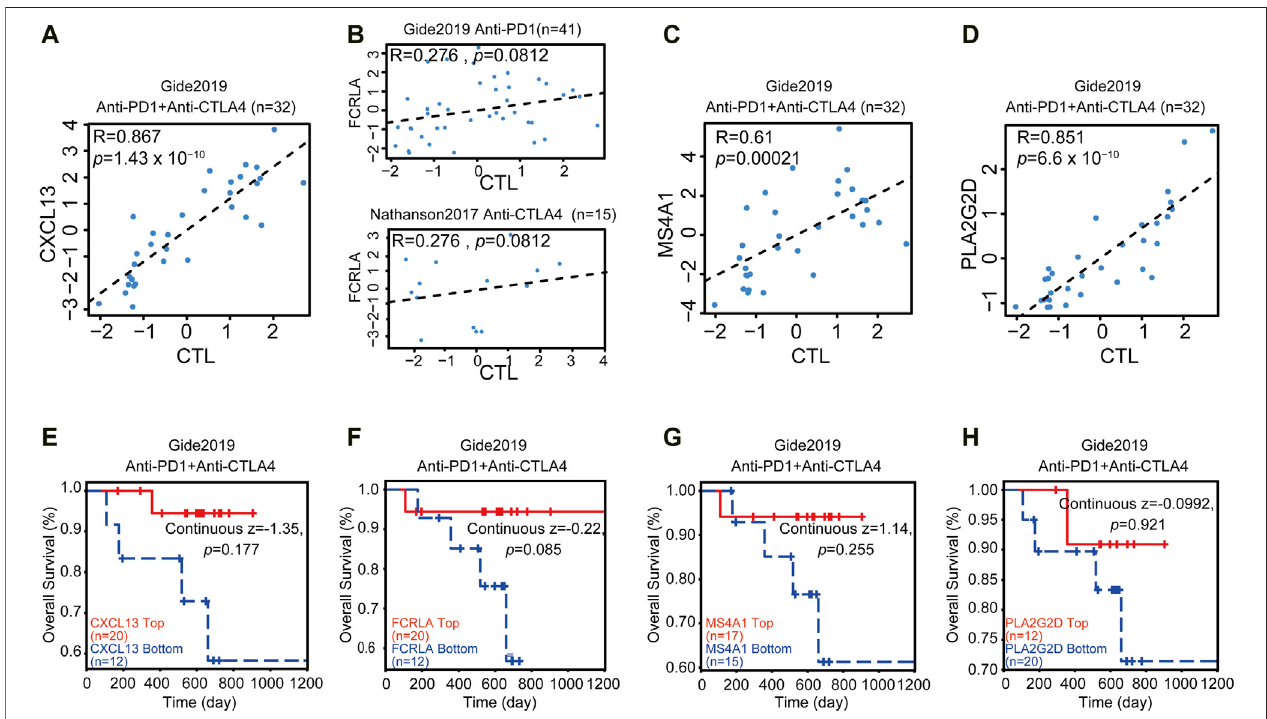
FIGURE6| CXCL13, FCRLA, MS4A1,and PLA2G2Dcorrelatedwithimmunotherapy. (A – D) Thescatterplotshows thecorrelation betweentheexpression levels ofCXCL13,FCRLA,MS4A1,PLA2G2D,andCTLin fi ltration.The x -axisshowsthelevelofCTLin fi ltrationineachmelanomasample.ThePearsoncorrelation(R)between theplottedvaluesisshownintheupperofeachplot. (E – H) TherelationbetweentheexpressionlevelsofCXCL13 (E) ,FCRLA (F) ,MS4A1 (G) ,andPLA2G2D (H) andthe overall survival rate of melanoma patients treated with anti-PD1 and anti-CTLA4. The p- value was calculated by testing the association between high/low expression and overall survival with the two-sided Wald test in a Cox-PH regression. Samples were split according to these four gene expression levels, respectively. Each Kaplan-Meier plot presents tumors in two groups: “ High expression ” (red) has above-average values among all samples, while “ Low expression ’ (blue) has values below average. The z-score ofCXCL13, FCRLA, MS4A1, and PLA2G2D were calculated by dividing the interaction coef fi cient by its standard error. p < 0.05 in the cox- PH